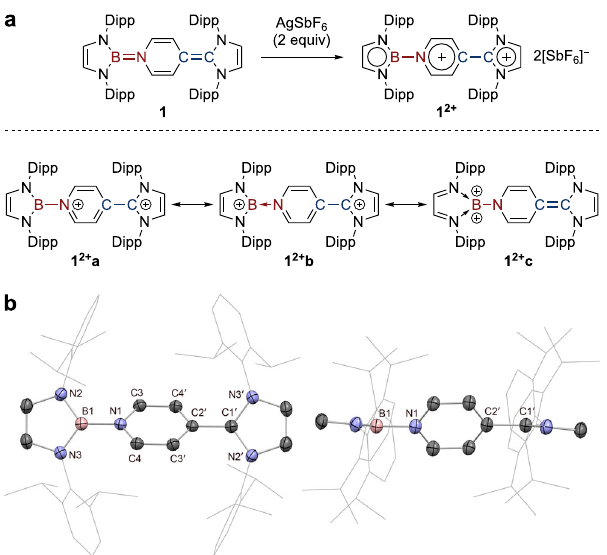
Fig. 6 Synthesis and characterization of dicationic organoboron analogue of Thiele ’ s hydrocarbon. a Synthesis of 1 2 + , showing contributing resonance structures. b Solid-state structure of 1 2 + [SbF 6 ] 2 with side view. For clarity, [SbF 6 ] − counter-anions and H atoms omitted, Dipp groups simpli fi ed as wireframes. Thermal ellipsoids set at 50% probability. Key